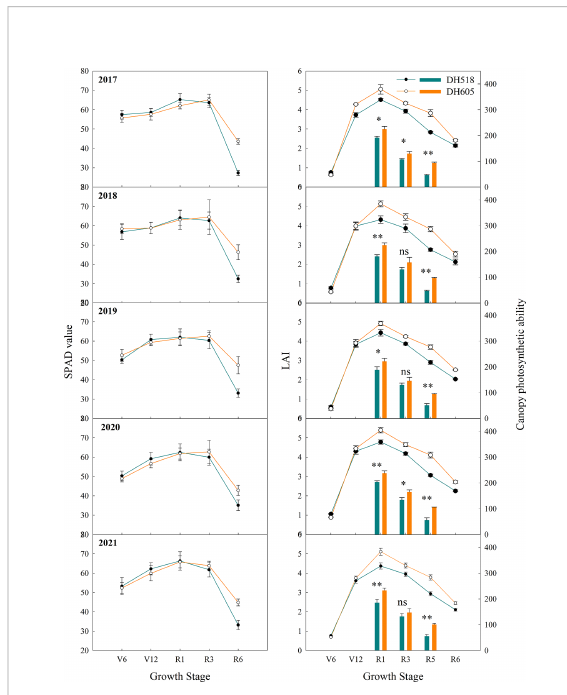
FIGURE 4 Chlorophyll relative content, leaf area index and canopy photosynthesis ability of summer maize hybrids with different growth duration (2017-2021). 2017, 2018, 2019, 2020 and 2021 were different years; DH518, Denghai518; DH605, Denghai605. V6, V12, R1, R3 and R6 were the sixth leaf stage, the 12th leaf stage, silking stage, milk stage and physiological maturity stage, respectively. ** and * indicated signi fi cantly different at the 0.01 and 0.05 probability levels, respectively. ns means there is no signi fi cantly different at the 0.05 probability